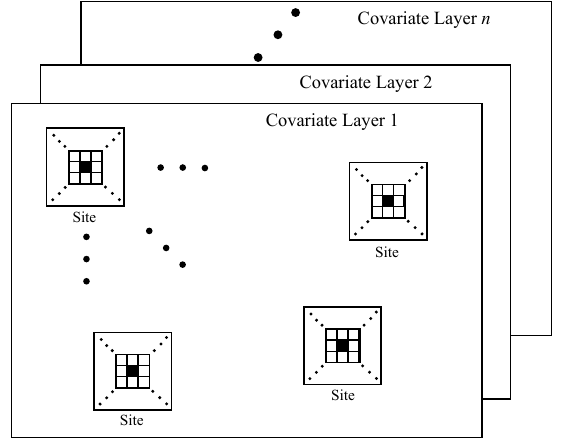
Figure 2 . Extraction of data pertaining to each sampling site, from each of the total n different covariate layers.